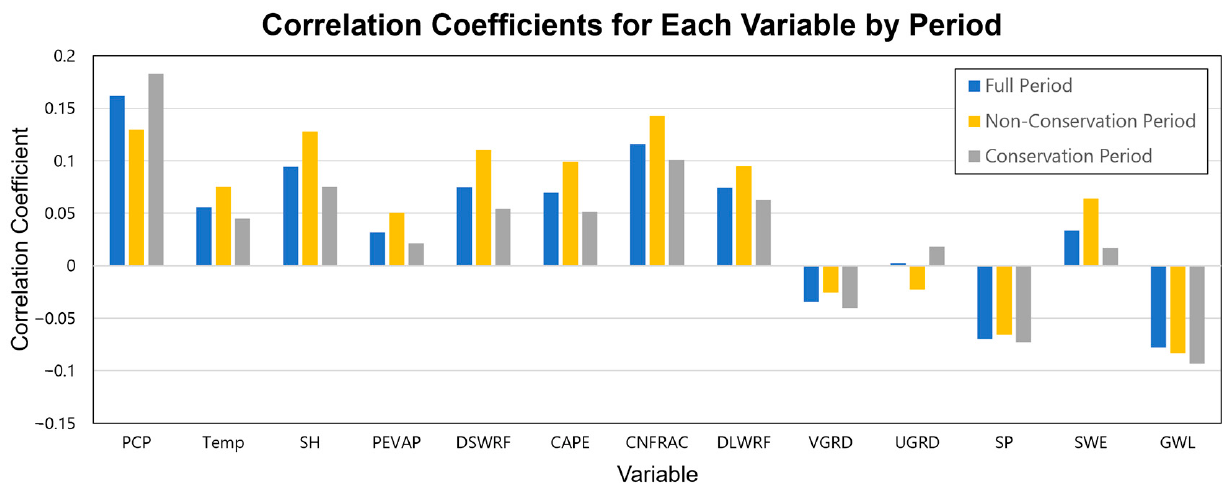
Figure 4. Correlation coefficients between each variable and the target variable by time period.